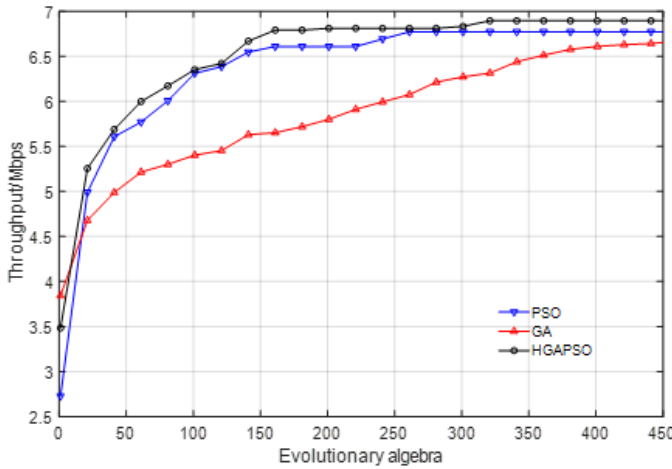
Figure 6. Comparison of the throughput by different